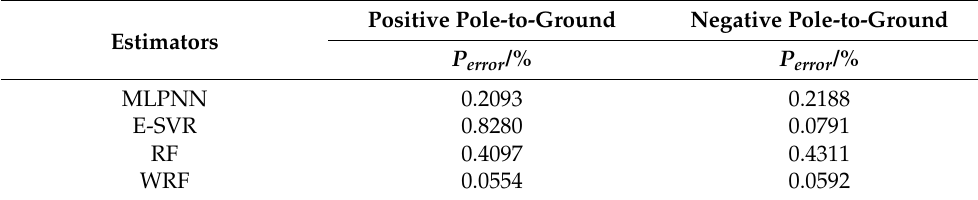
Table 6. Comparison with other